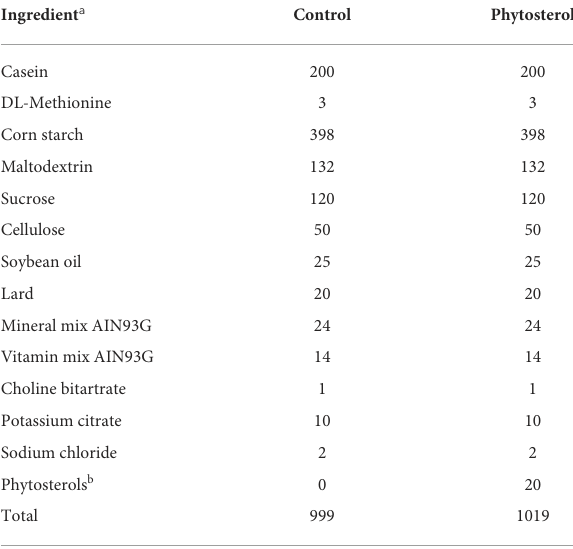
TABLE 1 Formulation of control and phytosterols-supplemented diets for C57BL/6J